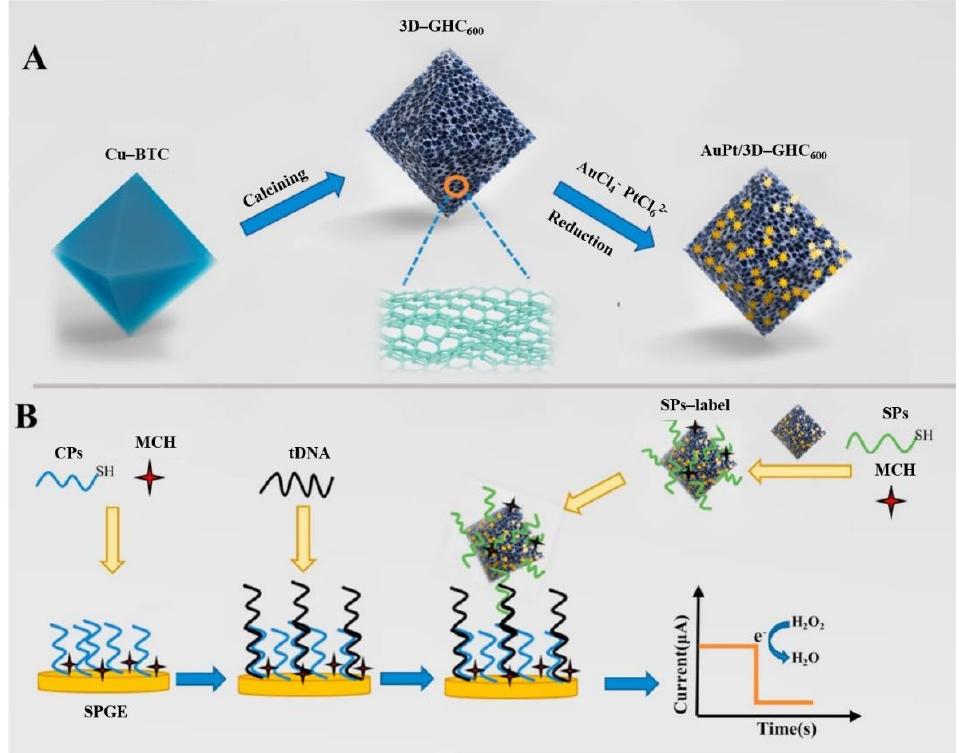
Figure 8. Schematic illustrations of ( A ) the synthetic processes of AuPt/3D-GHC 600 composite catalyst and ( B ) the fabrication steps of ctDNA electrochemical biosensor (Reprinted with permission from Ref. [47]. 2022, Chen et al).